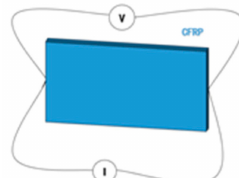
Figure 5. Electrical resistance change method with two